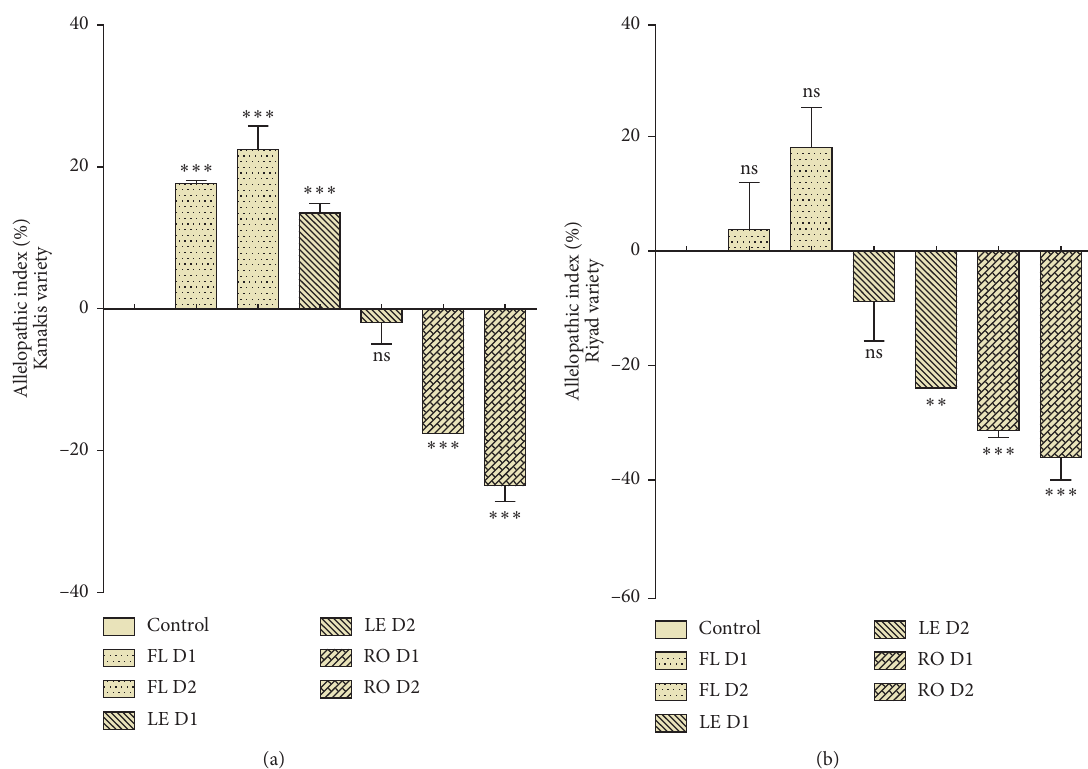
Figure 1: Impact of chamomile’s different parts on the allelopathic index (%) of the kanakis variety (a) and riyad variety of durum wheat (b). Data are expressed as mean ± SEM, n � 30, ns: not significant; ∗∗ p < 0 . 01; ∗∗∗ p < 0 . 001. FL: flowers, LE: leaves, RO: roots, and D1 and D2: 50g · L − 1 and 100g · L − 1 ,